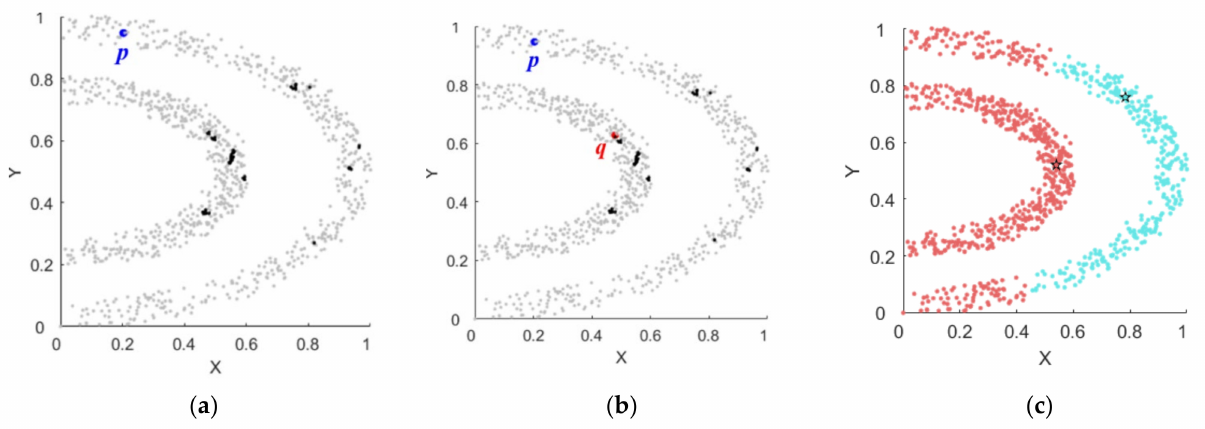
Figure 2. Best clustering result of DPC on Halfkernal (percent = 5.6) ( a ) point p and its big neighbors; ( b ) point p and its neighbor point q ; ( c ) clustering